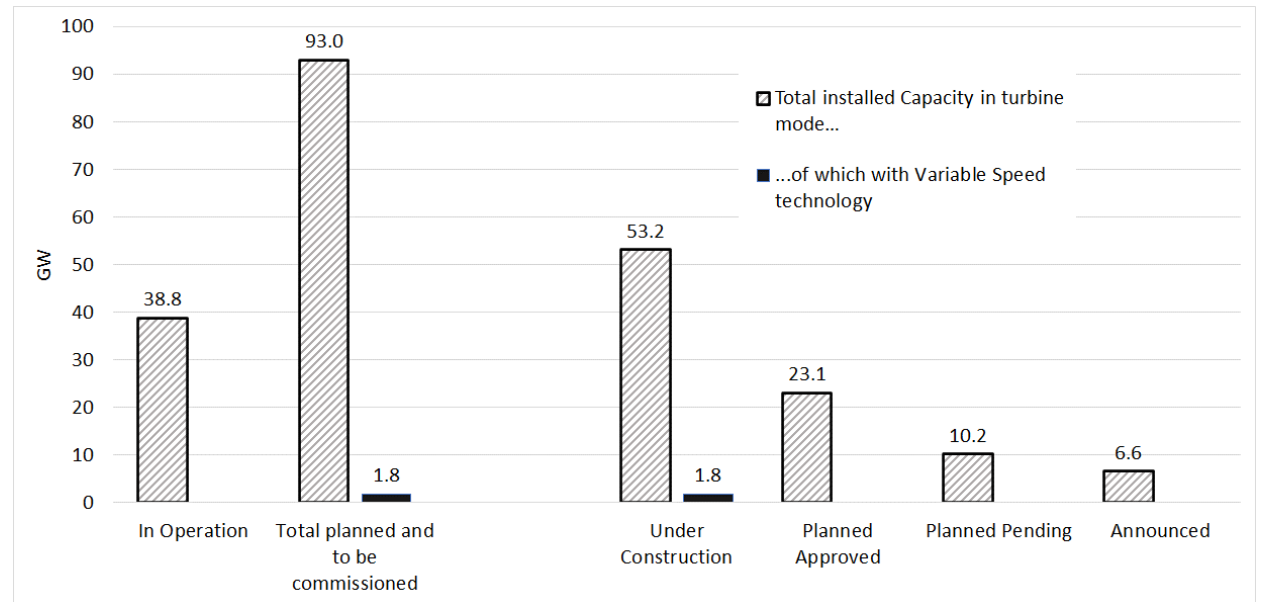
Figure 9. PHS status in China Q1 2022: operational and planned ( left ) and status detail of plants to be commissioned ( right ).